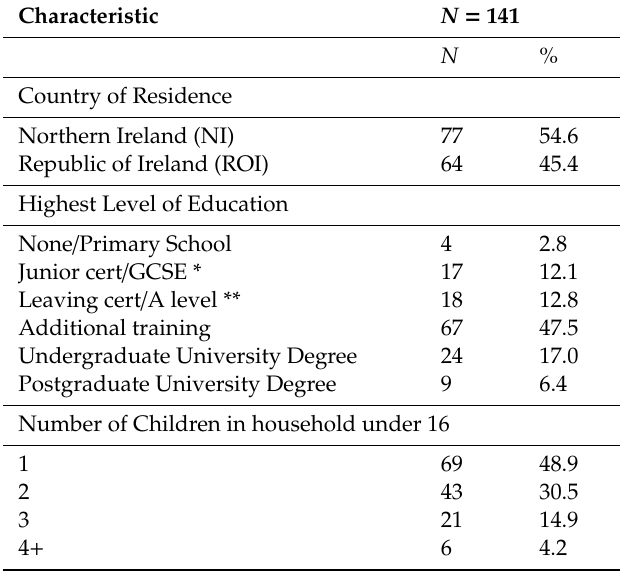
Table 2. Demographic and Sociodemographic Characteristics of Focus Group Participants ( N =